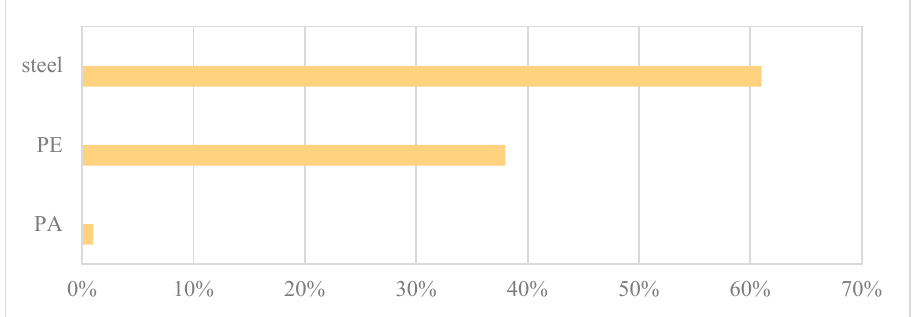
Figure 3. The gas network’s structure material distribution (steel and plastic networks: PE—polyethylene and PA—polyamide), expressed in % terms.